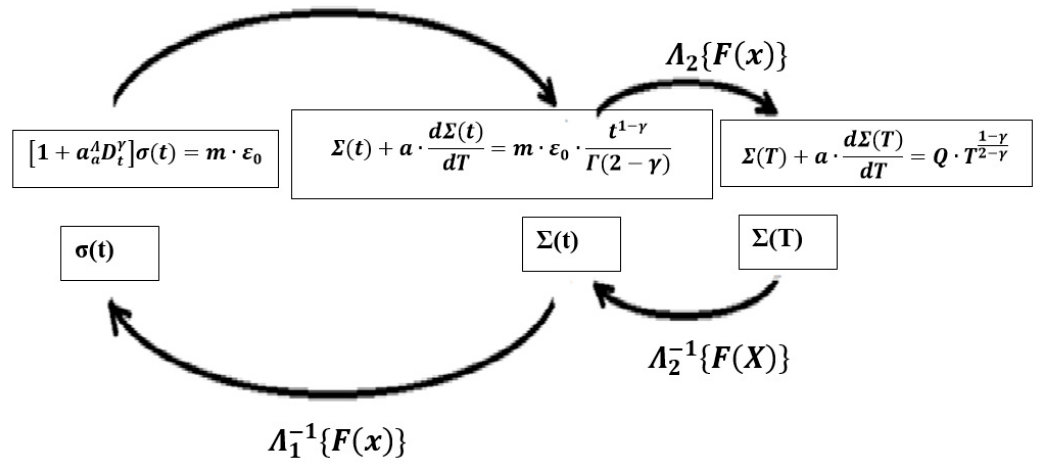
Figure 6. Λ -Transform in four steps for relaxation.